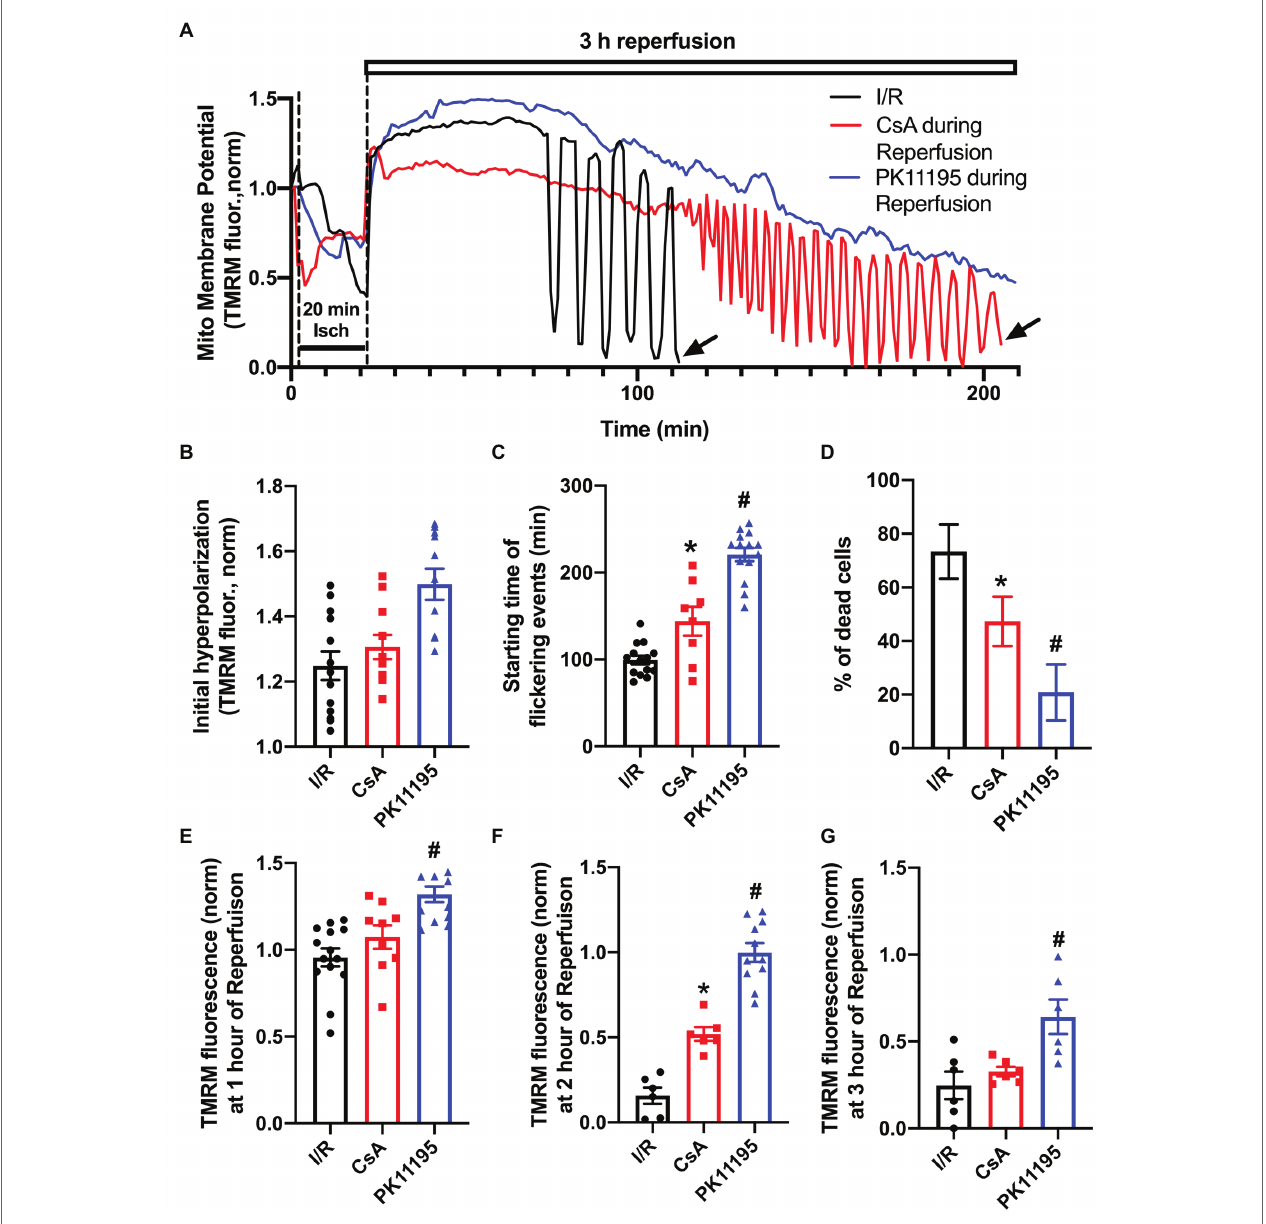
FIGURE 3 | Changes in mitochondrial membrane potential during simulated ischemia and reperfusion. (A) Shown are the traces reflecting changes in mitochondrial membrane potential during ischemia and reperfusion in the absence or presence of 1 μ M cyclosporin A (CsA) and 50 μ M PK11195 added at the onset of reperfusion. The abrupt ending in black and red tetramethylrhodamine methyl ester (TMRM) traces was due to cell death as indicated by the black arrows. (B) Summary data of the initial hyperpolarization at the onset of reperfusion. (C) Starting time of flickering events. (D) The percentage of dead cells observed during reperfusion compared to the pre-ischemia/reperfusion (I/R) levels. (E-G) The normalized TMRM levels measured at 1, 2, and 3 h of reperfusion. Data expressed as mean ± SEM. n = 3–5 animals per group. * p < 0.05 reflects a difference between untreated I/R cardiomyocytes and cardiomyocytes treated with 1 μ M CsA at the onset of reperfusion; # p < 0.05 reflects a difference between untreated I/R cardiomyocytes and cardiomyocytes treated with 50 μ M PK11195 at the onset of